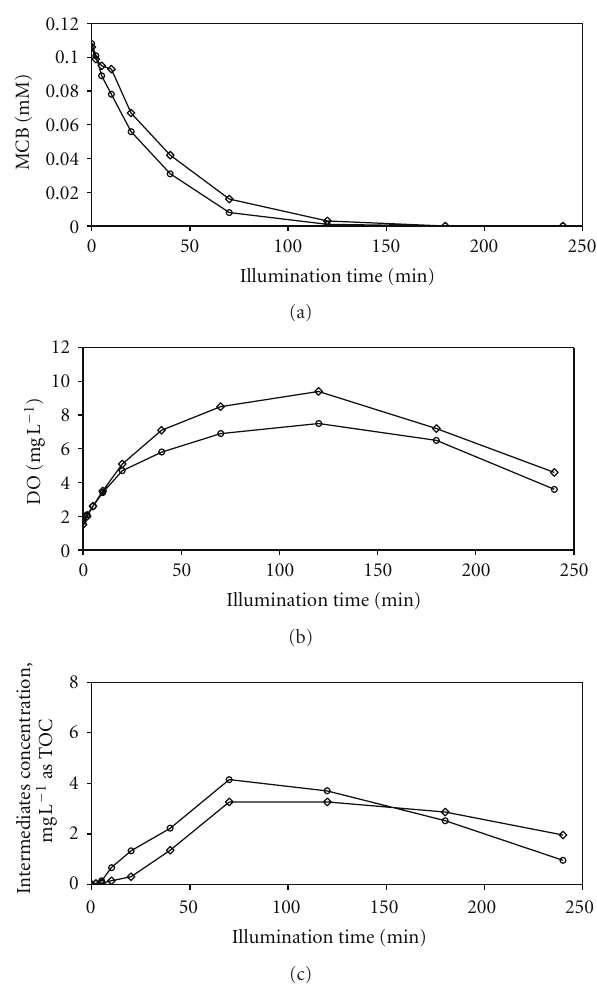
Figure 4: Comparison of the photocatalytic degradation of MCB under various H 2 O 2 : ( (cid:4) ) two-step addition and ( ♦ ) one-time